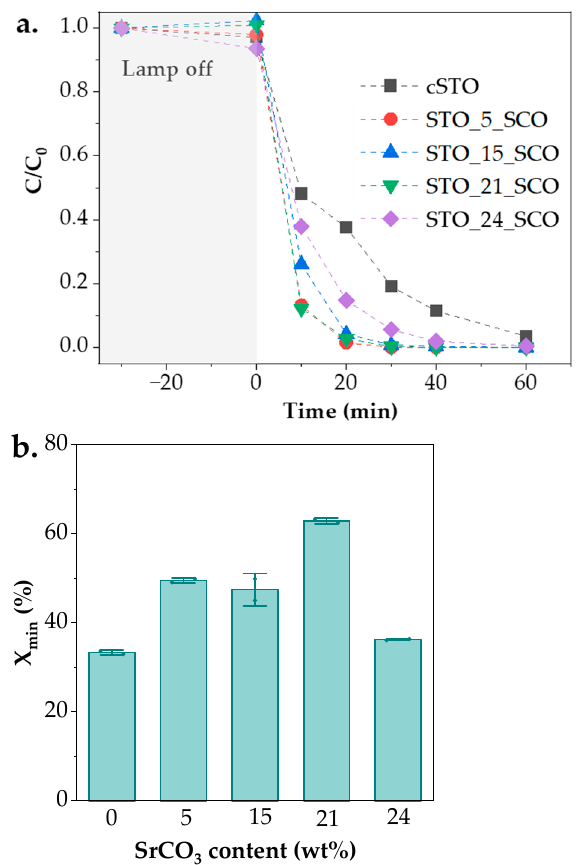
Figure 5. ( a ) The degradation curves of DCFNa and ( b ) the effect of SrCO 3 content on DCFNa mineralization after 4 h.